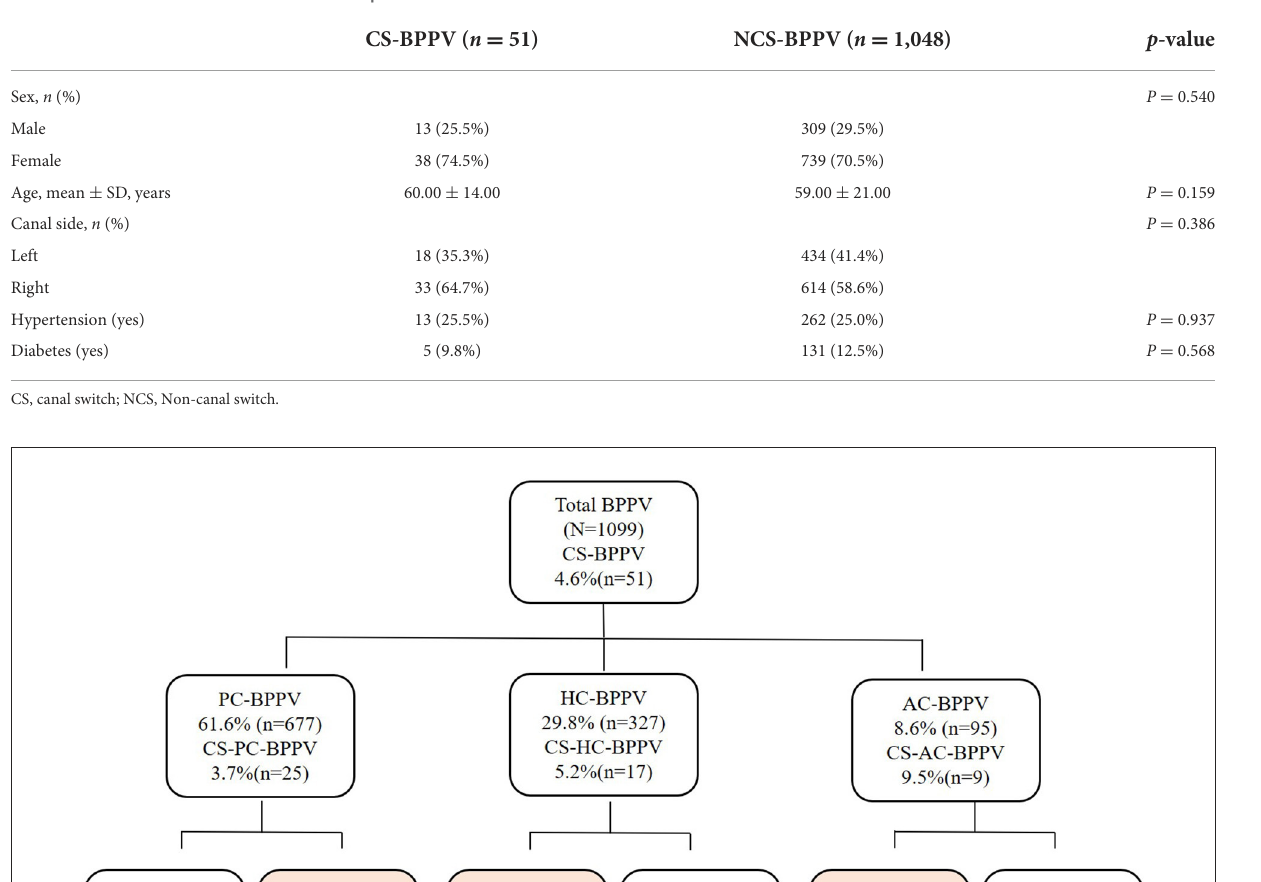
TABLE 1 Clinical baseline characteristics of patients with CS-BPPV and NCS-BPPV.